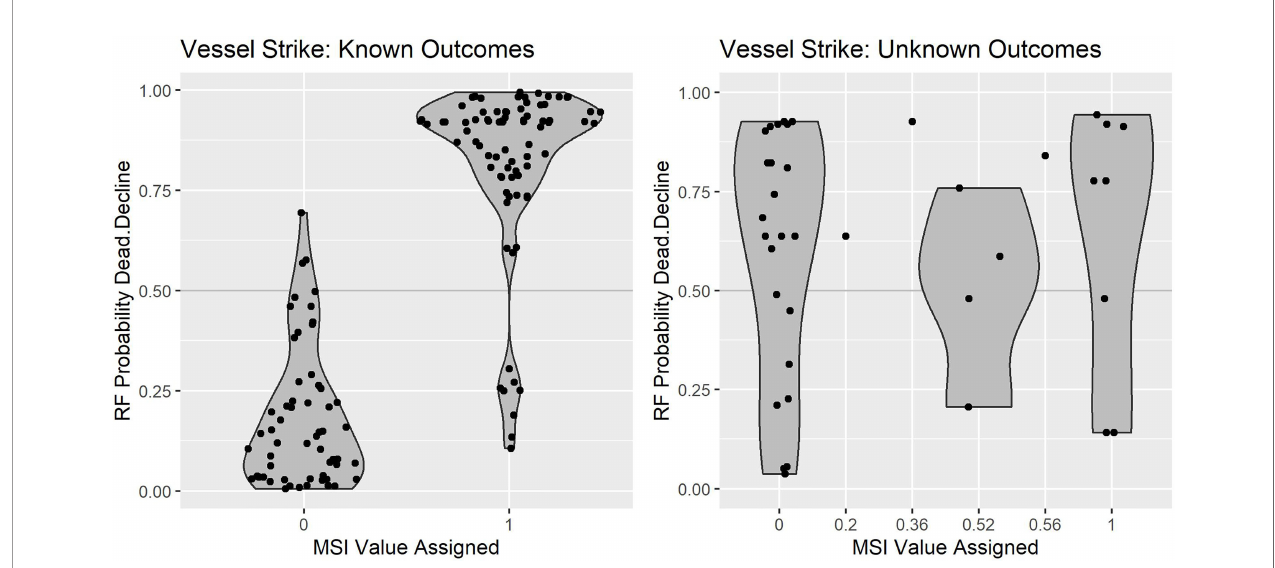
FIGURE 5 | RF predicted probabilities of ‘ Dead.Decline ’ vs MSI values assigned by scientists using current serious injury guidelines for vessel strike cases of right and humpback whales, combined. Non-serious injuries are represented by MSI values = 0 and serious injuries are represented by all other